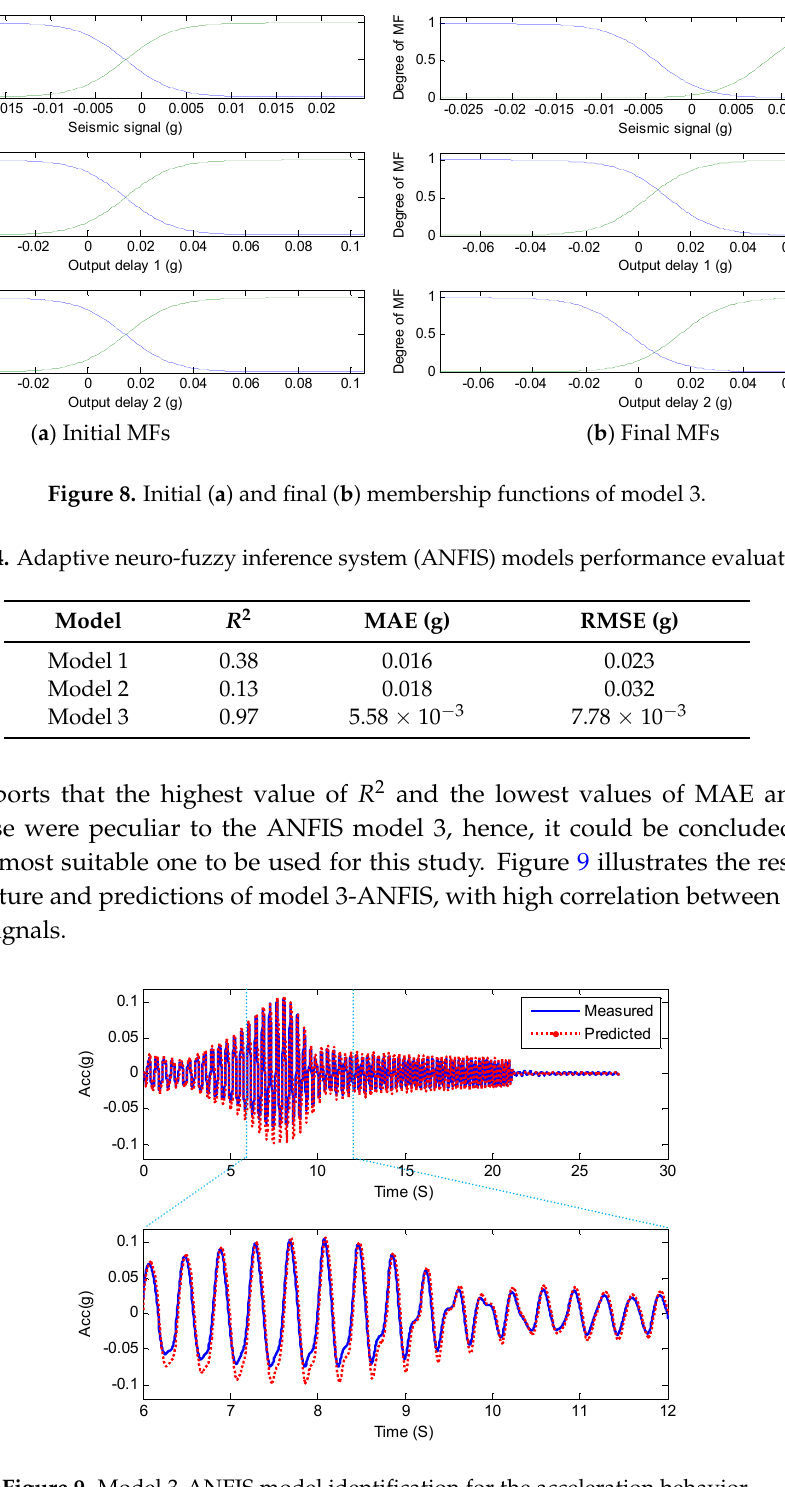
Figure 9. Model 3 ‐ ANFIS model identification for the acceleration behavior.